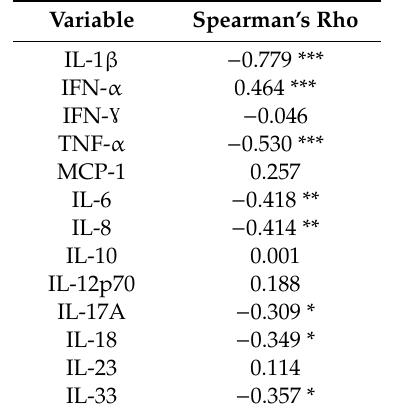
Table 7. Association of serum 25(OH)D concentration and cytokine levels in patients with heart failure for the 12-month follow-up.